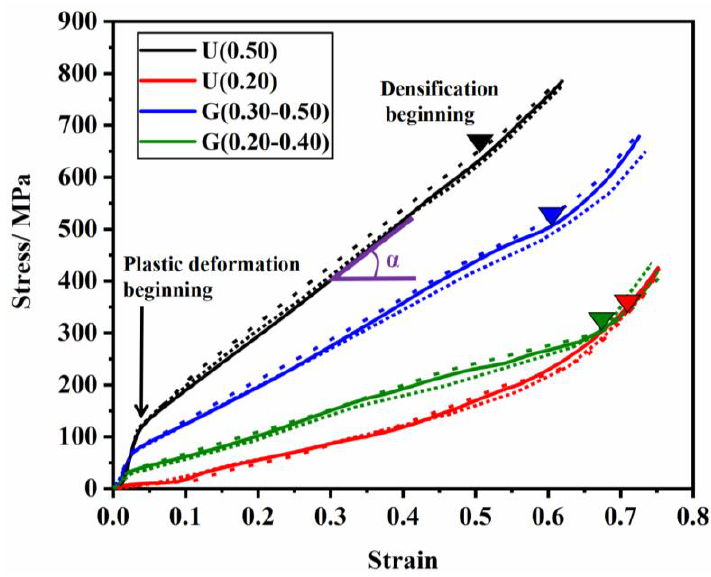
Figure 7. The stress-strain curves of lattice structures by compression test. As expected, the stress-strain curves of FGLSs were positioned between those of ULSs with RD = 0.5 and 0.20. The stress-strain curves of specimens seem to be relative to their RD. As the RD decreases, four main differences arise: Firstly, the slope of a straight line fitted to the elastic stage, which is defined as the elastic modulus of materials, gradually becomes smaller and smaller. This indicates that the ability to resist the deformation weakened